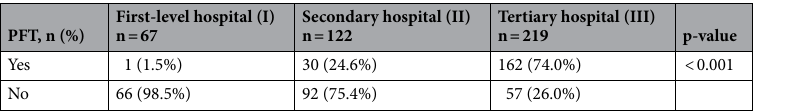
Table 2. Proportion of patients receiving PFT during the first seeking-treatment visit among different levels of hospitals. PFT pulmonary function test.